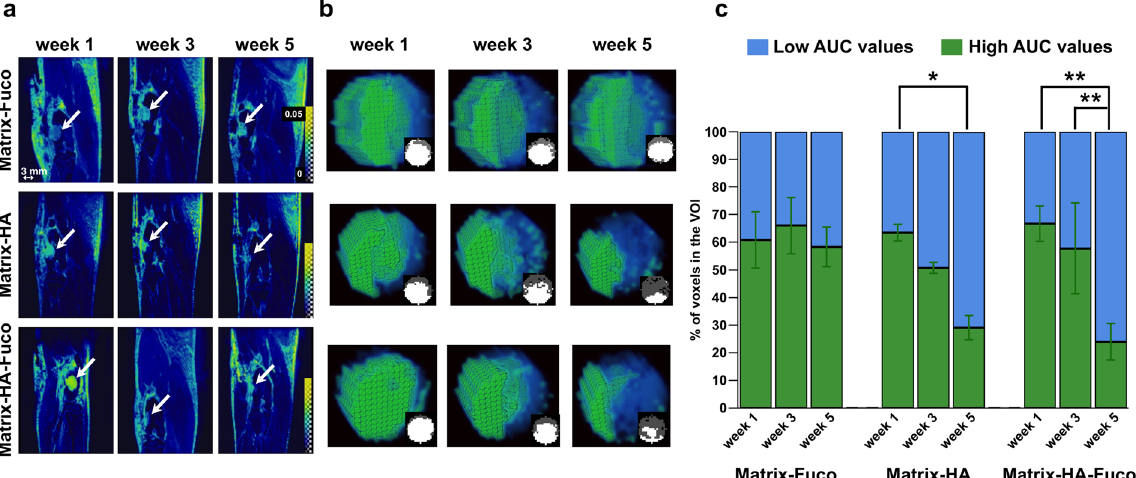
Figure 6. ( a ) 3D parametric AUC maps of the bone defects that received the biomaterials. A slice showing each defect at each time point was extracted from the 3D maps. For each biomaterial group, the same rat is displayed over weeks 1, 3 and 5. The white arrows show the defect. The color scale represents the AUC values between 0 and 0.05. ( b ) 3D rendering of each biomaterial defect extracted and magnified at weeks 1, 3 and 5 post- implantation. Voxels with high AUC values are colored in green and voxels with low AUC values are colored in blue. The small inserts are 2D slices extracted from the 3D AUC maps, located at the center of the defect. The amount of fast-perfused voxels (with low AUC) increased over time in the Matrix-HA and Matrix-HA-Fuco filled defects. In contrast, no change with time was measured in the defects filled with Matrix-Fuco biomaterial. ( c ) Quantitative analysis of the percentage of pixels with high (green) and low (blue) AUC from the extracted Volume-of-Interest (VOI) for the 3 different biomaterials at weeks 1, 3 and 5. Values are means ± Standard Deviations. Significant differences between each week are indicated with * p < 0.05 and ** p ≤ 0.01. Of note, the percentage obtained on the Matrix-HA-Fuco filled defects at week 5 was significantly different to the ones obtained at week 1 and week 3. Similarly, the percentage obtained on the Matrix-HA filled defects at week 1 was significantly different to the ones obtained at week 5. On the contrary, the percentages obtained on the Matrix- Fuco filled were not significantly different at any time